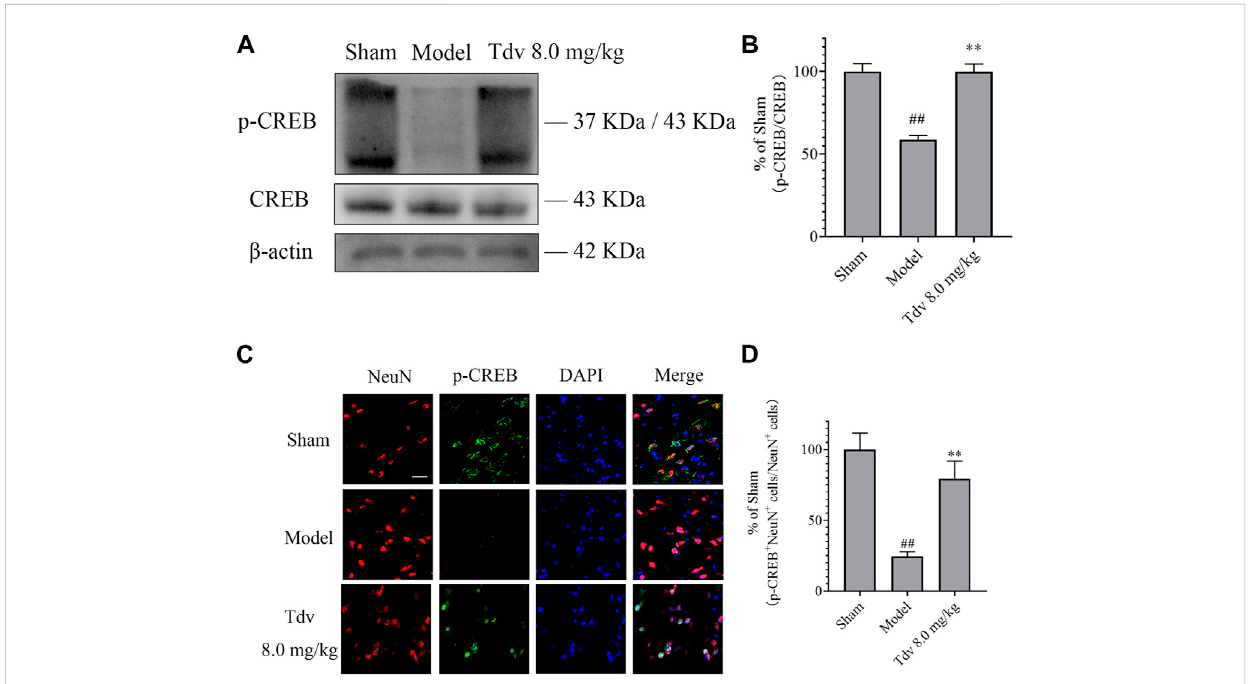
FIGURE 4 Toludesvenlafaxine induced the activation of the CREB pathway to promote the functional recovery after stroke. (A) The expression of p-CREB; (B) Statisticalresults of Western blot; (C) Immuno fl uorescenceof p-CREB and NeuN,scale bar = 50 μ m; (D) Statistical results ofp-CREB + cells. Westernblot ofdataismean±SD,n=3. ## p < 0.01 versus sham,and** p < 0.01 versus model. p-CREB + cells ofdata arealsomean± SD,n=3. ## p < 0.01 versus sham, and ** p < 0.01 versus